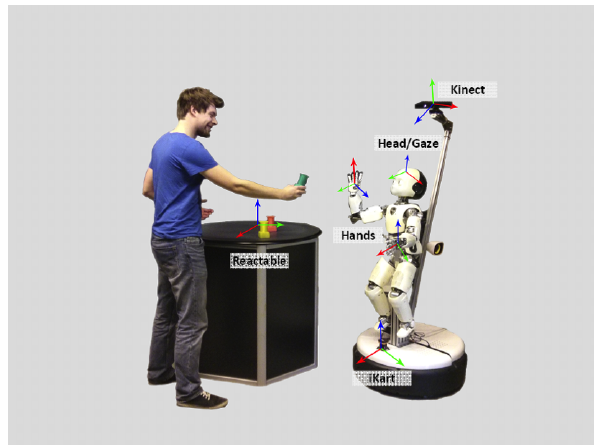
Figure 2: A human-robot interaction platform showing all of the different reference frames used for actions (Reactable, iKart, Kinect, the robot’s hands and